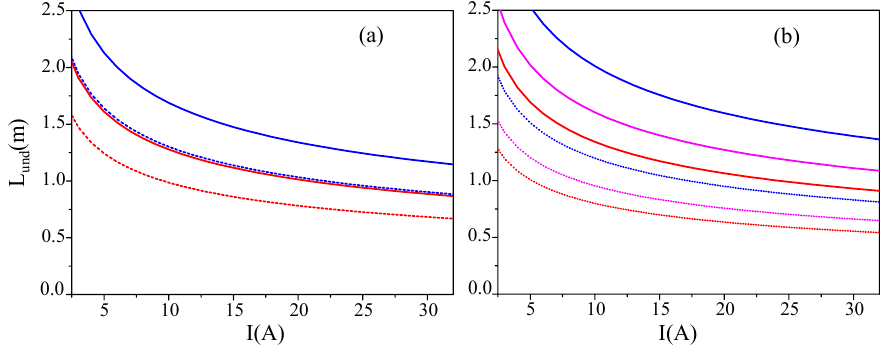
Figure 3. Undulator length L und versus electron beam peak current I(A). Solid curves represent the long bunch cases, dotted curves represent the short bunch cases. Window ( a ): λ = 36 µ m, λ w = 3.5 cm, γ = 55.5 (red curves); λ = 13.2 µ m, λ w = 3.5 cm, γ = 81.5 (blue curves). Window